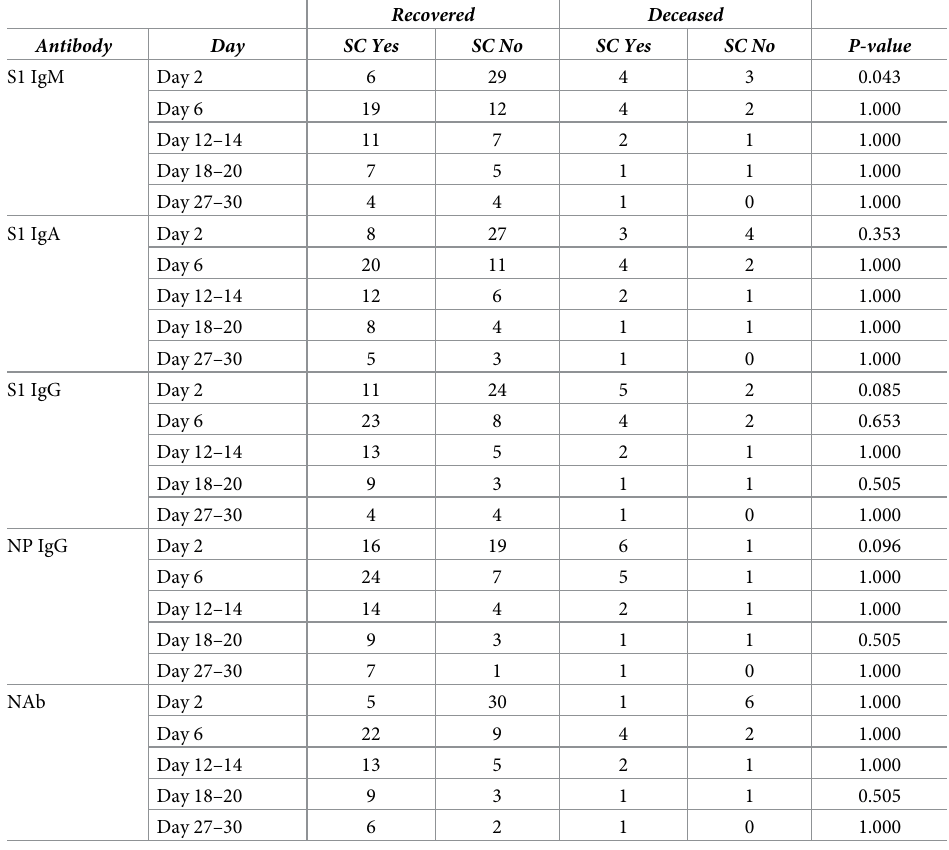
Table 3. Seroconversion in COVID-19 patients according to